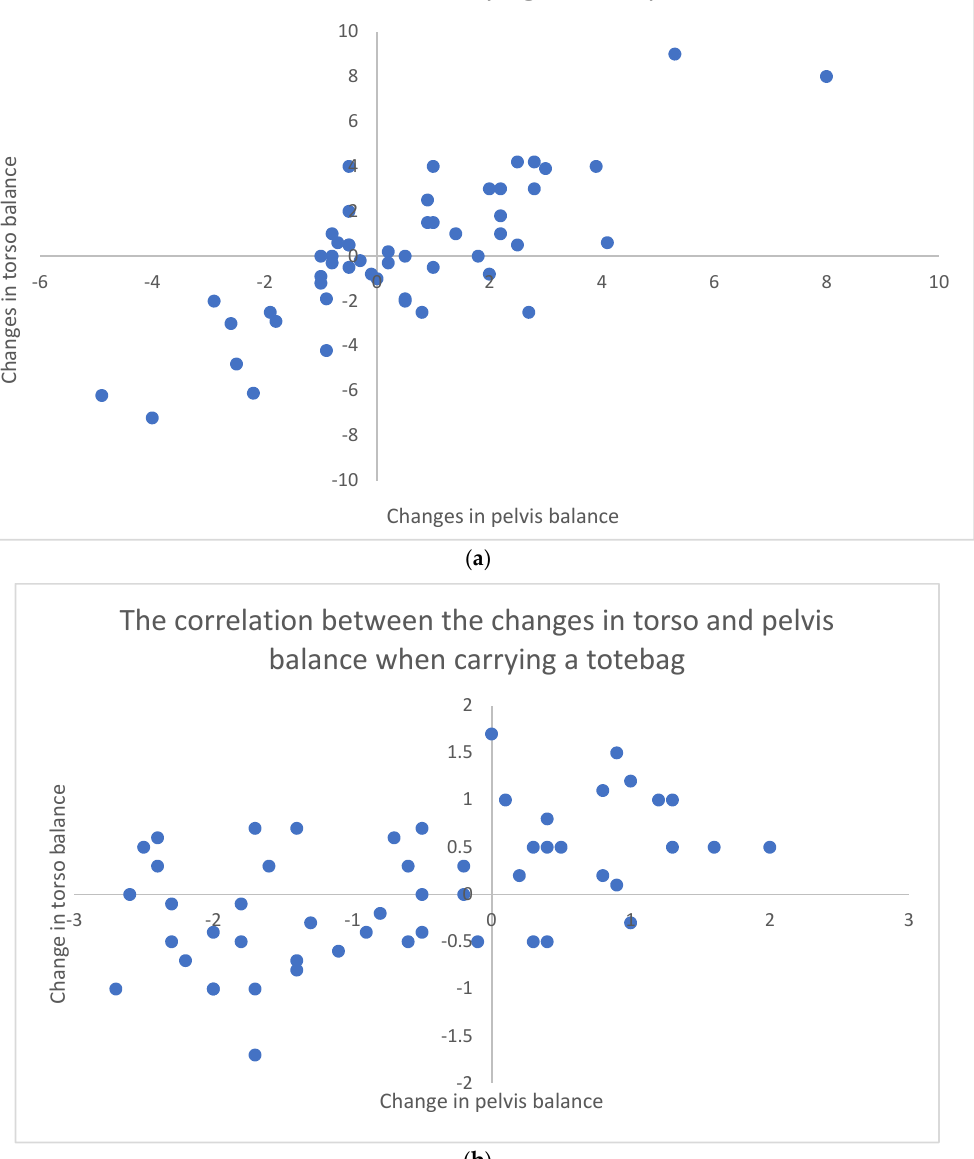
( c ) Figure 8. ( a ) The correlation between torso and pelvis when carrying a backpack (R = 0.82); ( b ) the correlation between torso and pelvis when carrying a tote bag (R = 0.49); and ( c ) the correlation between torso and pelvis when carrying a sling/crossbody bag (R = 0.94). 4. Discussion Generally, assessing body balance includes static, quasi-mobility, and mobility tasks. Since they often complement each other, numerous assessment methods have been devel- oped in recent decades with complex and corresponding balancing devices and measure- ment tasks. However, most of them, which serve as diagnostic tools, are complex and re- quire professional skills for interpretation [17,25,26,57,58]. Others may serve as balance